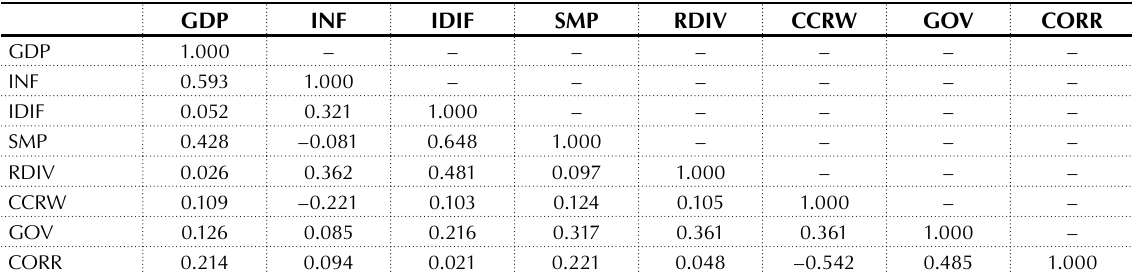
Table 2. Correlation matrix of the independent variables